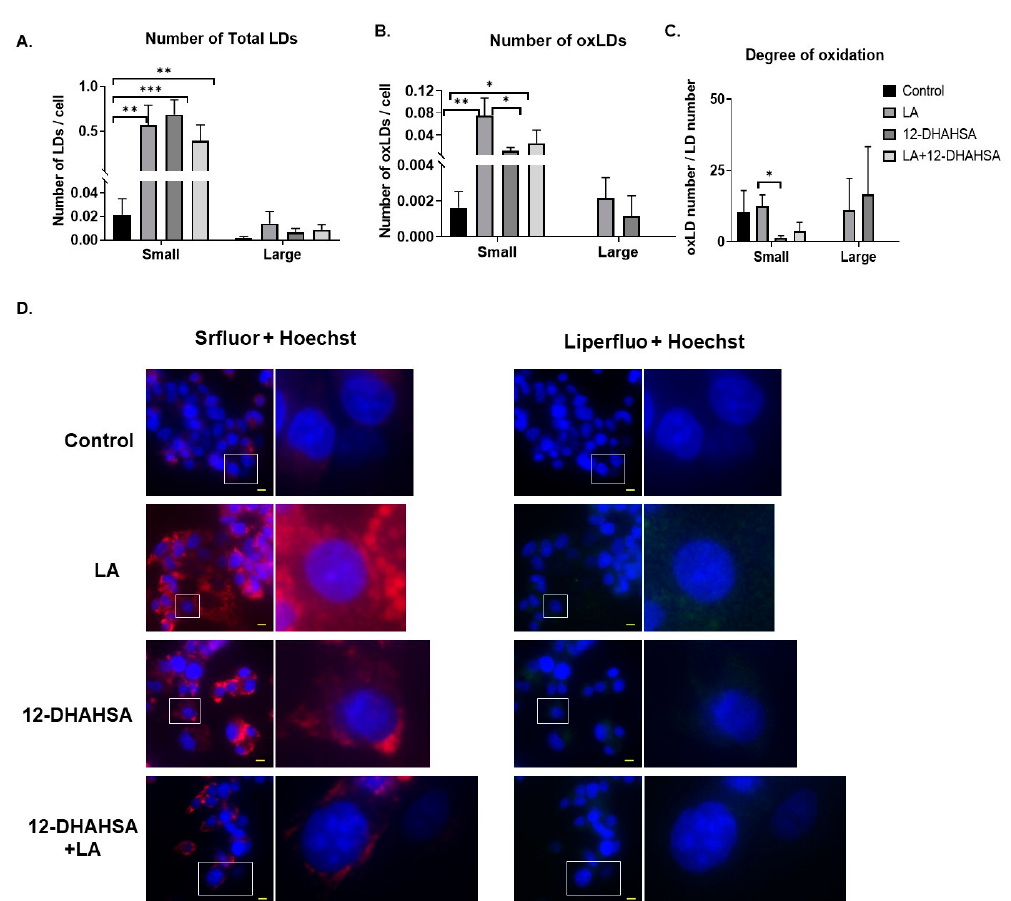
Figure 6. Effect of 12-DHAHSA (125 µM) on oxidation of LA-induced LDs in C3A cells. ( A ) Number of total LDs. ( B ) Number of oxLDs. ( C ) Degree of oxidation. Small LDs are < 3 µm 2 and large LDs are ≥ 3 µm 2 and are quantified by analyzing fluorescent images with ImageJ software. ( D ) Fluorescent images showed neutral lipid (red), lipid peroxide (green), and nuclei (blue). The scale bar shown in each image is 10 µ m. Columns and bars represent the mean ± SEM ( n = 3). Student’s t -test with * p < 0.1, ** p < 0.05, *** p < 0.01.